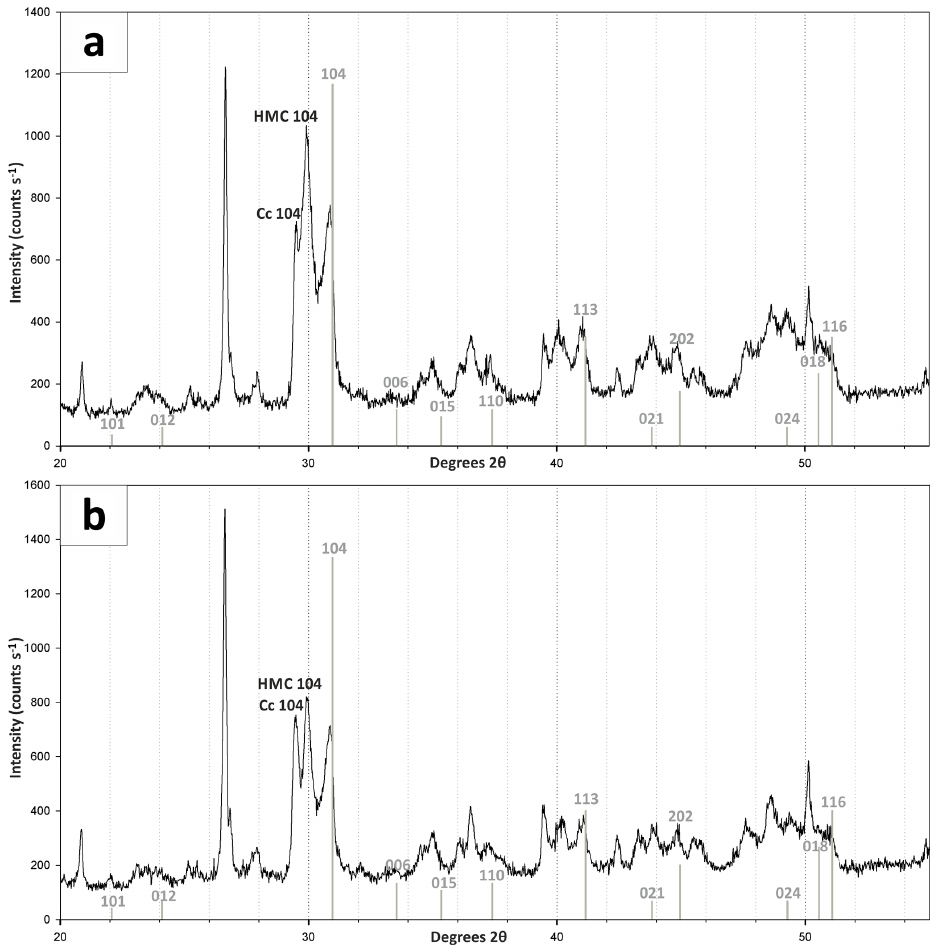
Figure 6. X-ray diffractograms of bulk Lake Neusiedl sediment (a) from 2cm and (b) from 27.5cm depth. Positions of dolomite peaks are marked in grey. Position of major calcite (Cc 104) and high-magnesium-calcite (HMC 104) peaks are also indicated. Note that typical dolomite ordering peaks could not be identified in the XRD spectra. Furthermore, a figure and a list containing major peaks of identified mineral phases is provided in the